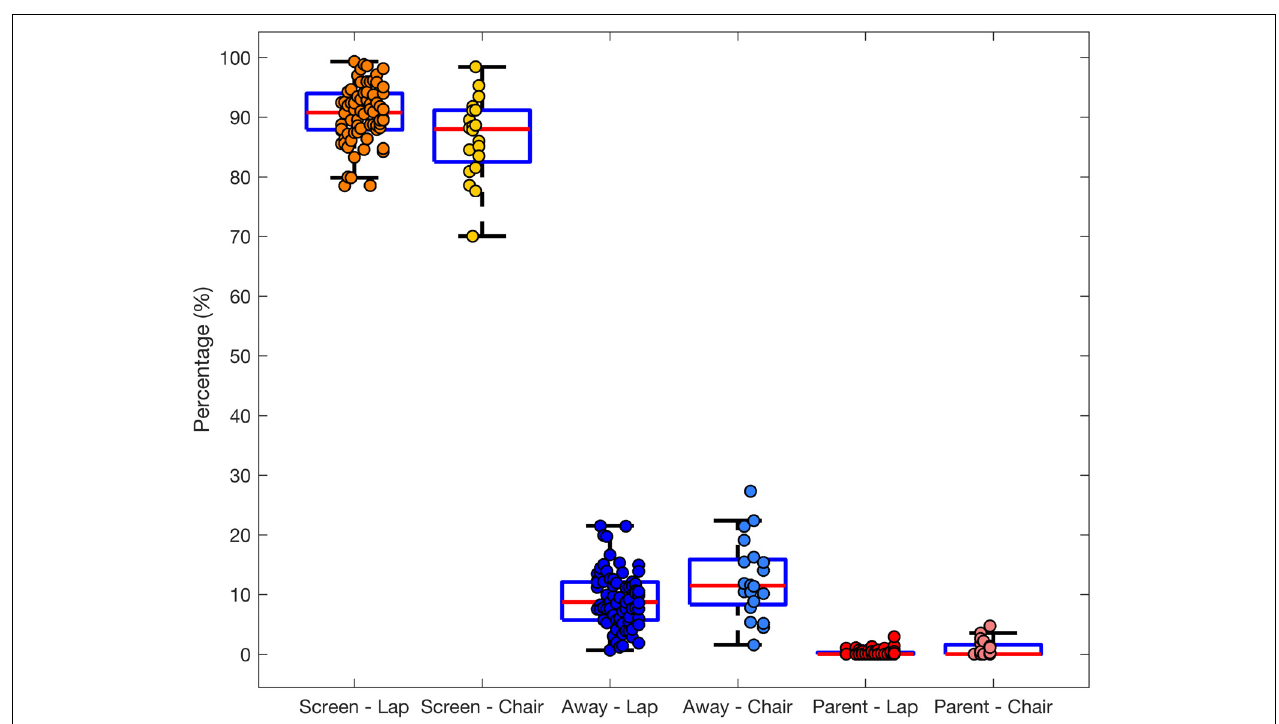
FIGURE 2 | Boxplot with overlaid dots (individual participants) representing the total duration of looking at the screen, away from it or at the parent for infants seated on a lap ( n = 74) or a chair ( n =